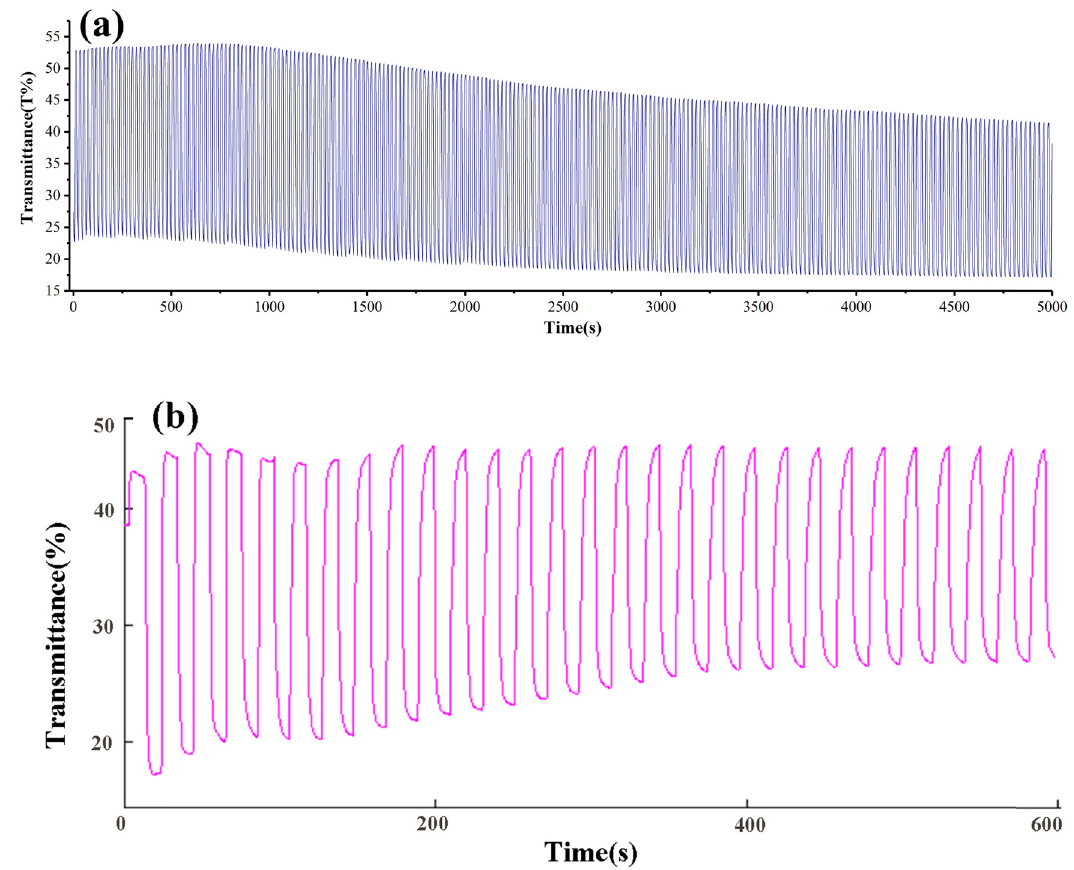
Figure 11: The coloring kinetics of fi lms ( a ) PEDOT:PSS/EMI - TFSI for 250 circles and ( b ) PEDOT:PSS for 30